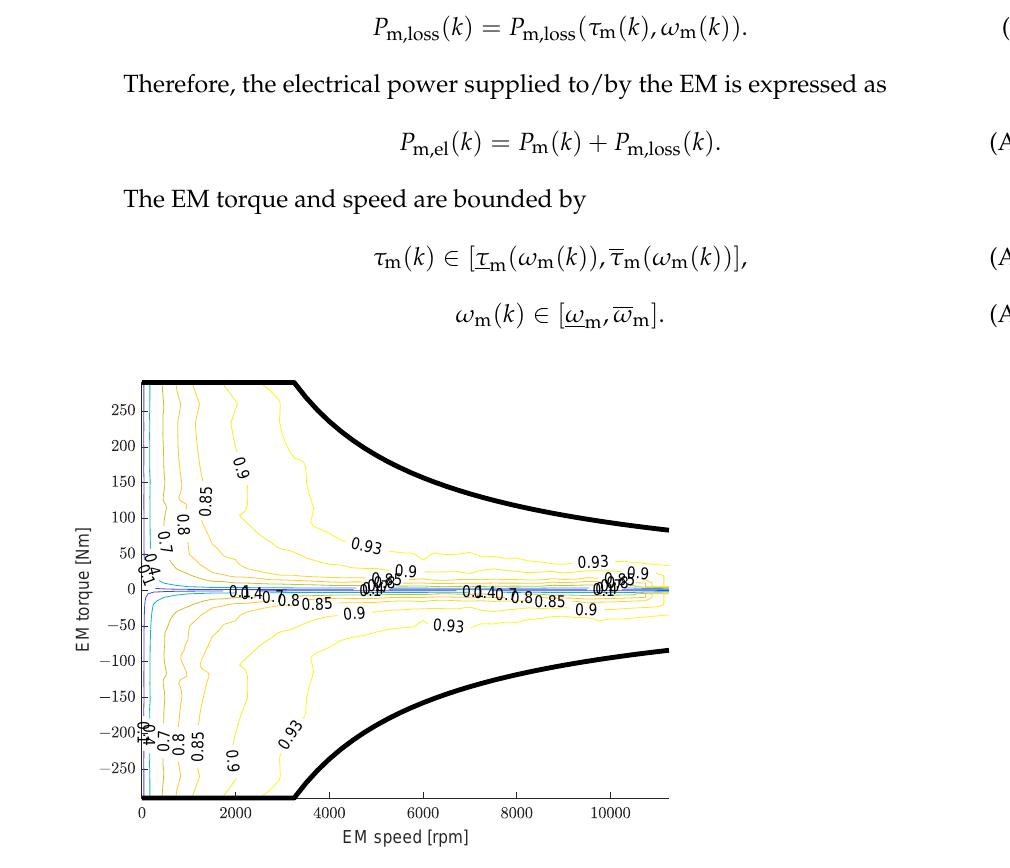
Figure A3. Efficiency map of the EM including the DC-AC